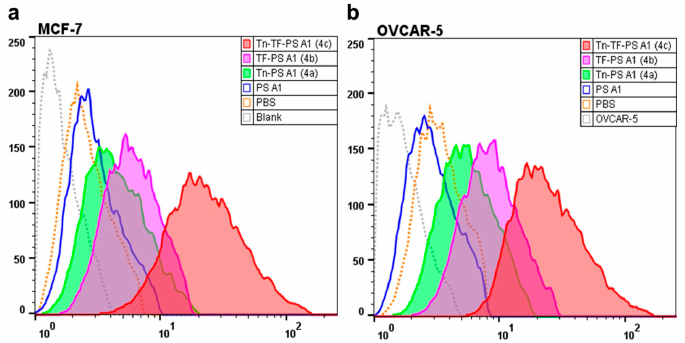
Figure 2. Flow cytometry study with antiserum obtained from mice immunized with 1 , 4a , 4b , or 4c and human tumor cell lines. ( a ) MCF-7 human breast tumor cell line. ( b ) OVCAR-5 human ovarian tumor cell line.